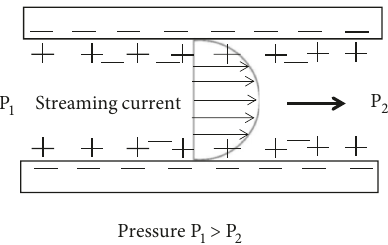
Figure 3: Development of streaming potential when an electrolyte is pumped througha capillary (a porous medium is made of an array of